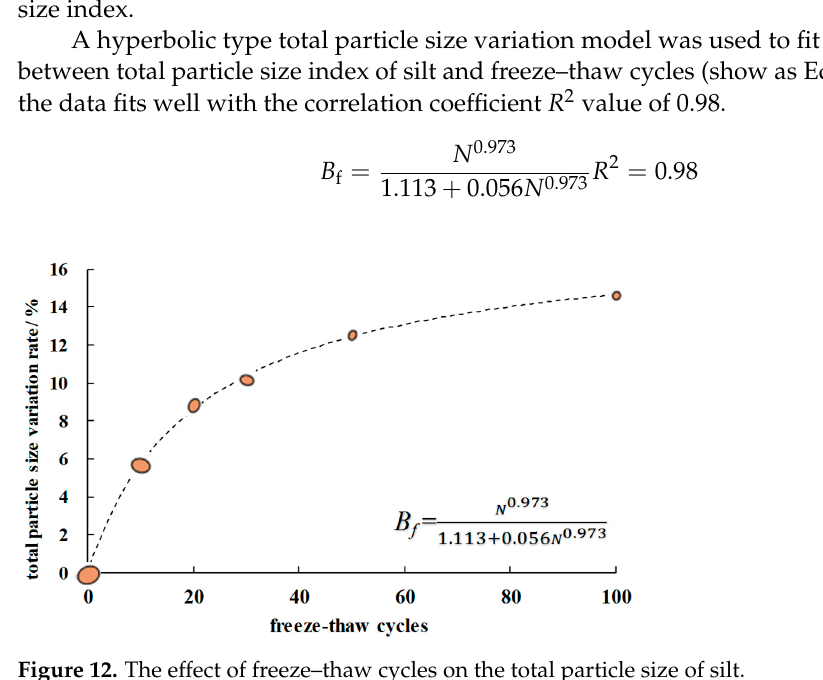
Figure 11. The sphericity curves of silt.